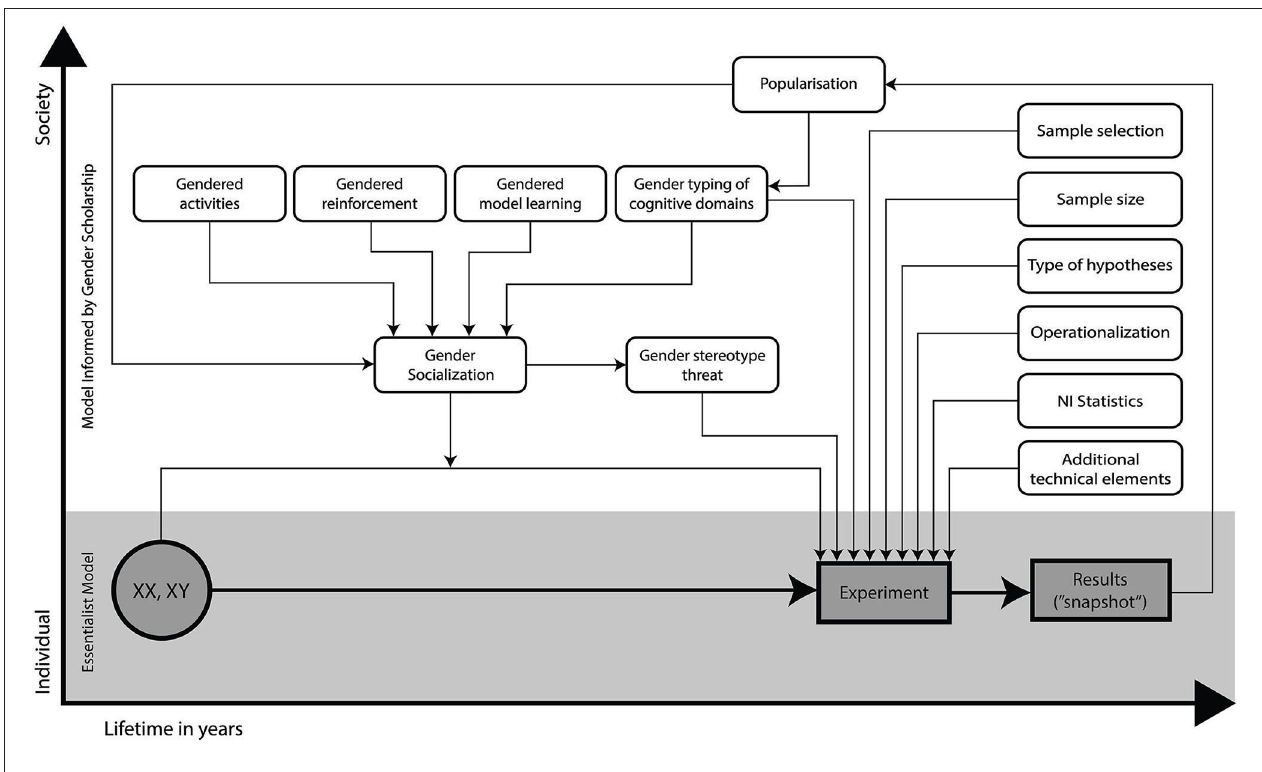
FIGURE 1 | Comparison of “Essentialist” vs. “Social Context” models of experimental design in sex/gender research . (Shaded section): the essentialist model that is often implicit in NI sex/gender research: female-male differences appear to be directly traceable to initial genetic differences between female and male